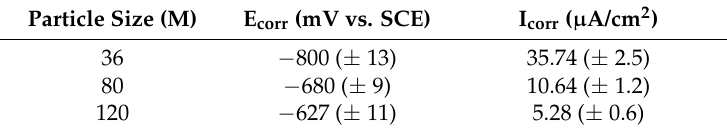
Table 2. Tafel polarization parameters of the ground specimens with different abrasive particle sizes.